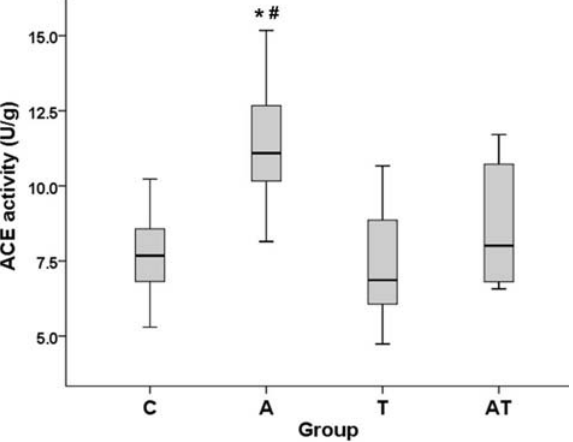
Figure 3. Effect of nandrolone decanoate (A), taurine (T) and their combination (AT) on plasma levels of stable end products of NO metabolism – nitrate and nitrite (NO x ) – in rats. There was a signi fi cant decrease of NO x in the A and AT groups vs control (C) group (n=8 for each group). The box-and-whisker plots report the minimum, 25% percentile, median, 75% percentile, and maximum values. *P=0.01 vs the C group (one-way ANOVA and Tukey ’ s post hoc